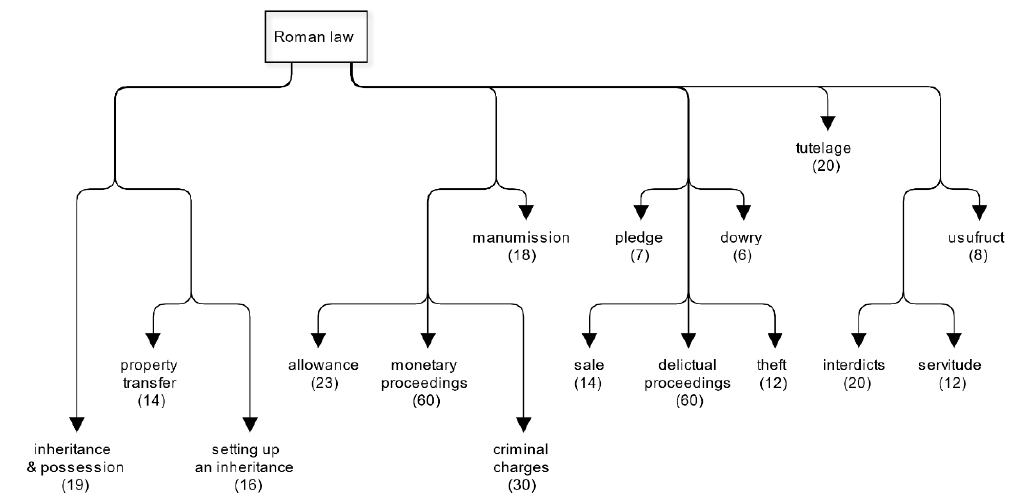
Figure 6. A simplified empirical conceptual tree-map of Roman law.